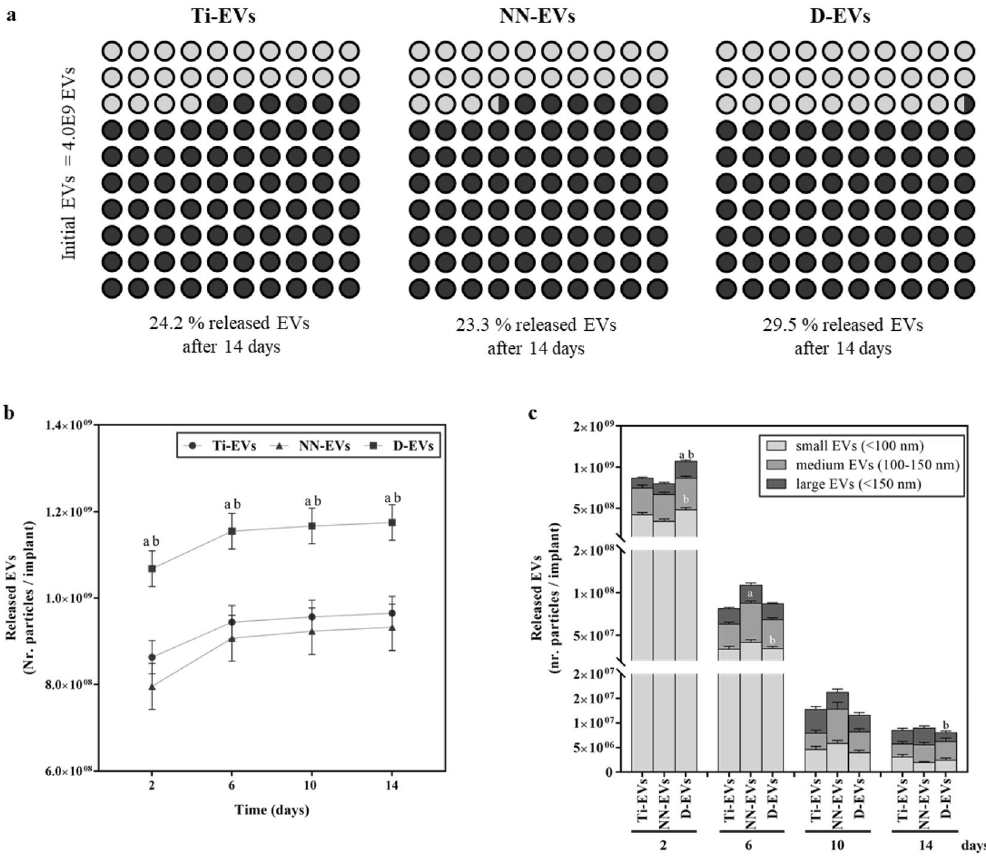
Figure 3. pEVs release over time. ( a ) Percentage of released EVs after 14 days for Ti-EVs, NN-EVs and D-EVs. ( b ) Accumulative pEVs release for each functionalized implant measured after 2, 6, 10 and 14 days. ( c ) Released pEVs according to size at 2, 6, 10 and 14 days. Small EVs (pale gray) correspond to sizes smaller than 100 nm, medium EVs (gray) are between 100 and 150 nm and large EVs (dark gray) are larger than 150 nm. Values represent the mean ± SEM and they were compared by ANOVA, using DMS as post hoc for data of 2 days and 10 days, and Games-Howell as post hoc for data of 6 days and 14 days. Three different samples were evaluated per group and statistically significant differences were considered for p < 0.05 and represented with a compared to Ti-EVs and b compared to